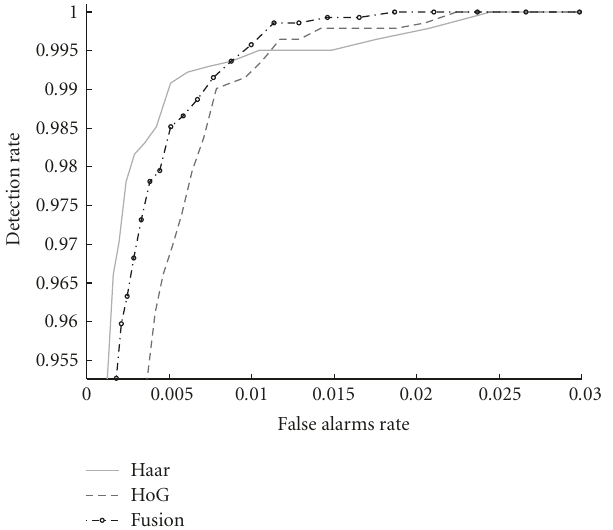
Figure 7: Number of features retained by each layer for a detector with 1000 negative